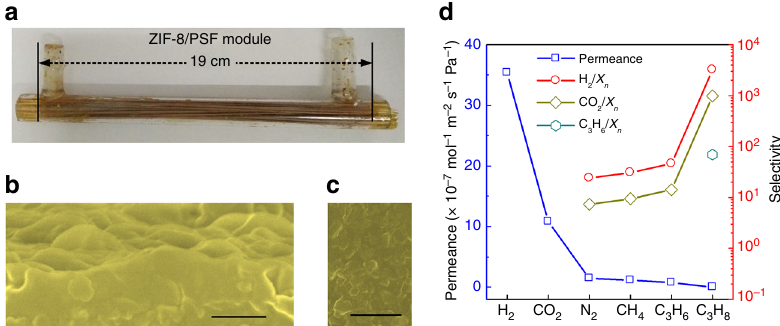
Fig. 4 ZIF-8 hollow fi bre module. a Optical photograph of ZIF-8 hollow fi bre membrane module. SEM images of b top and c cross-sectional view of the ZIF-8 membrane in module. Scale bar , 400 nm (in b ) and 2 μ m (in c ). d Gas permeation behaviours of various gases through the ZIF-8 hollow fi bre membrane